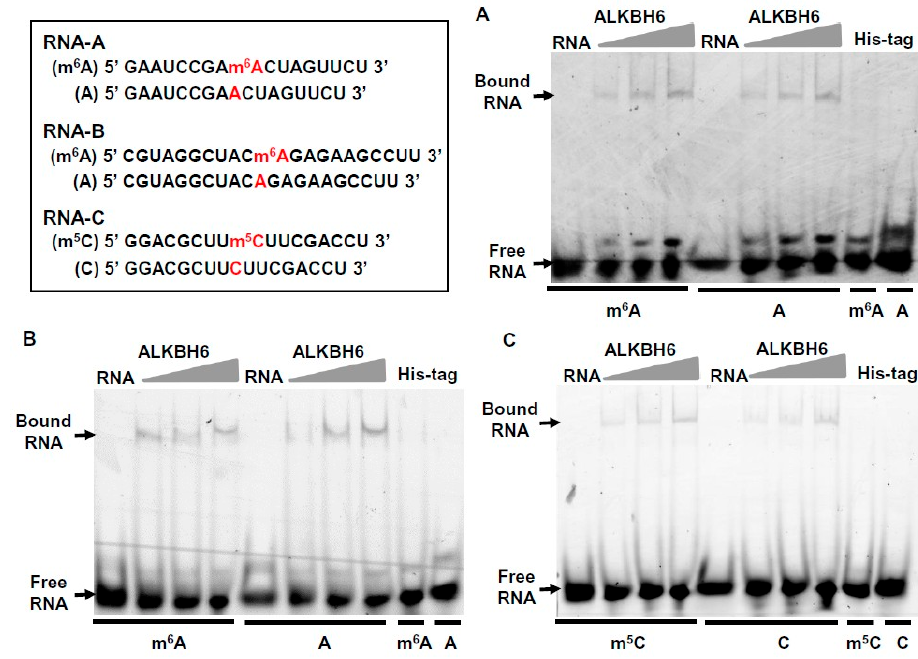
Figure 6. RNA-binding ability of the ALKBH6 protein. Electrophoretic mobility shift assay showing the binding between the ALKBH6 protein (3, 5, and 7 µ M) and the synthetic ( A ) RNA-A, ( B ) RNA-B, or ( C ) RNA-C. The modified adenine and cytosine bases are indicated in red. The 5 ′ -fluorescein-labeled RNA substrates were mixed with the purified protein, and the reaction mixtures were separated on a 6% native acrylamide gel. The binding products were detected using an image analyzer.